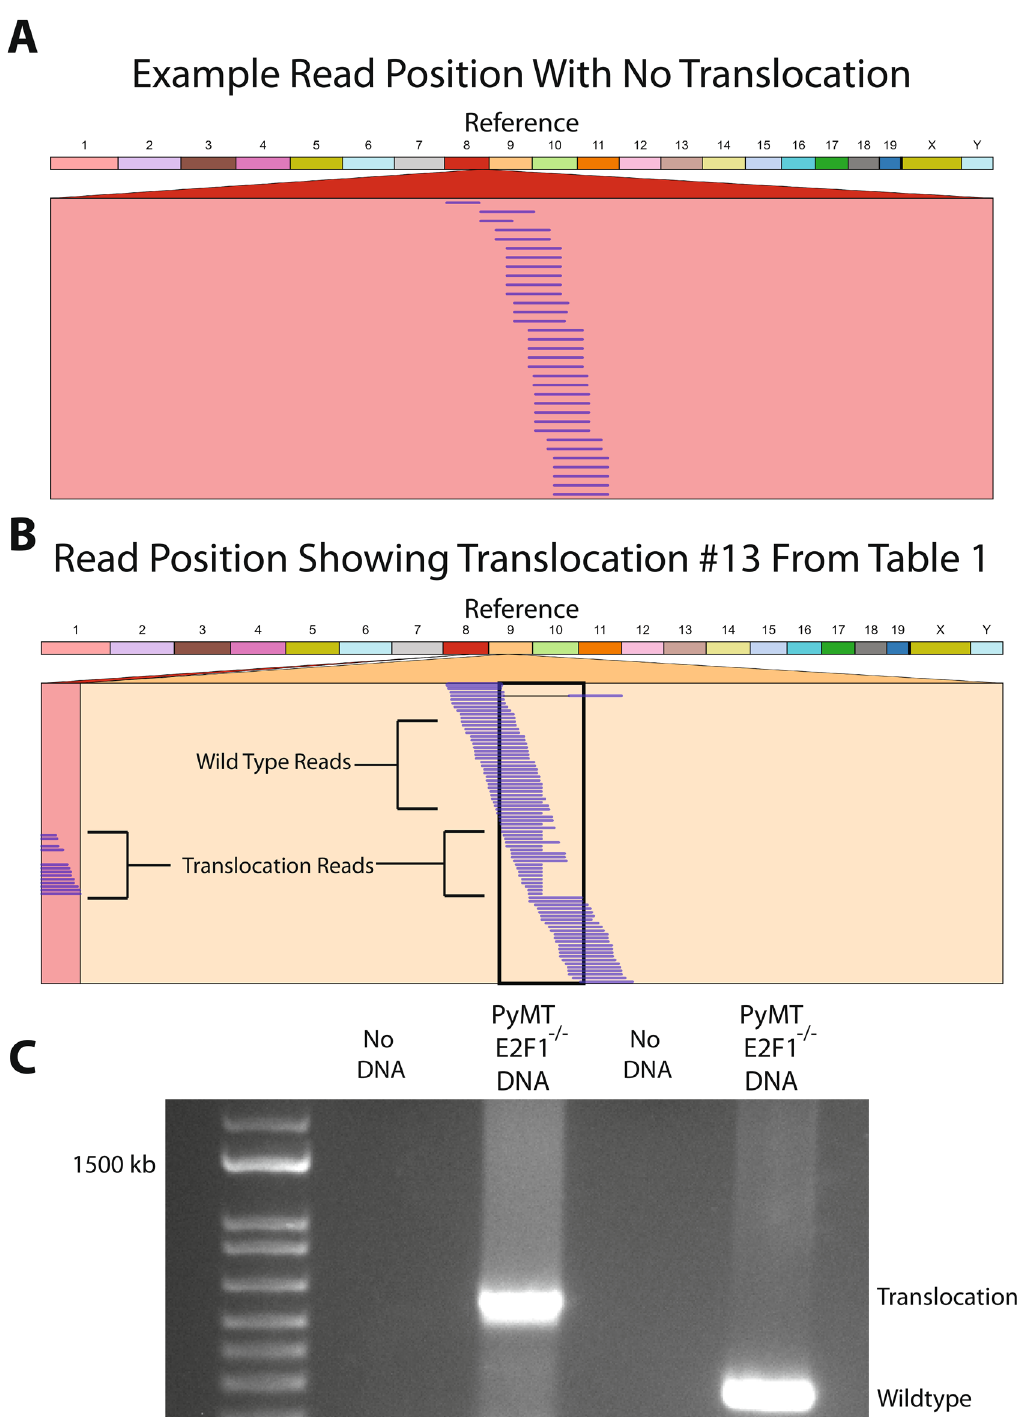
Figure 6. Verification of translocation calls. ( A ) Example of a GenomeRibbon plot where no structural variation occurs. The top colored bands represent each chromosome of the mouse, and the red box below represents the location searched within a sample’s bam file. Each line within that box represents a different read. ( B ) A GenomeRibbon plot representing translocation number 13 from Table 1. Translocated reads are shown between chromosome 9 and chromosome 8. ( C ) Gel image of the chromosome 8/9 translocation from the GenomeRibbon plot above. DNA was from a PyMT E2F1 −/− tumor. Both translocation and wild type tumor DNA were amplified. Translocated reads were amplified using a primer set flanking the region where the two translocated ends ligate. Gel image is cropped to remove excess, see supplemental for full